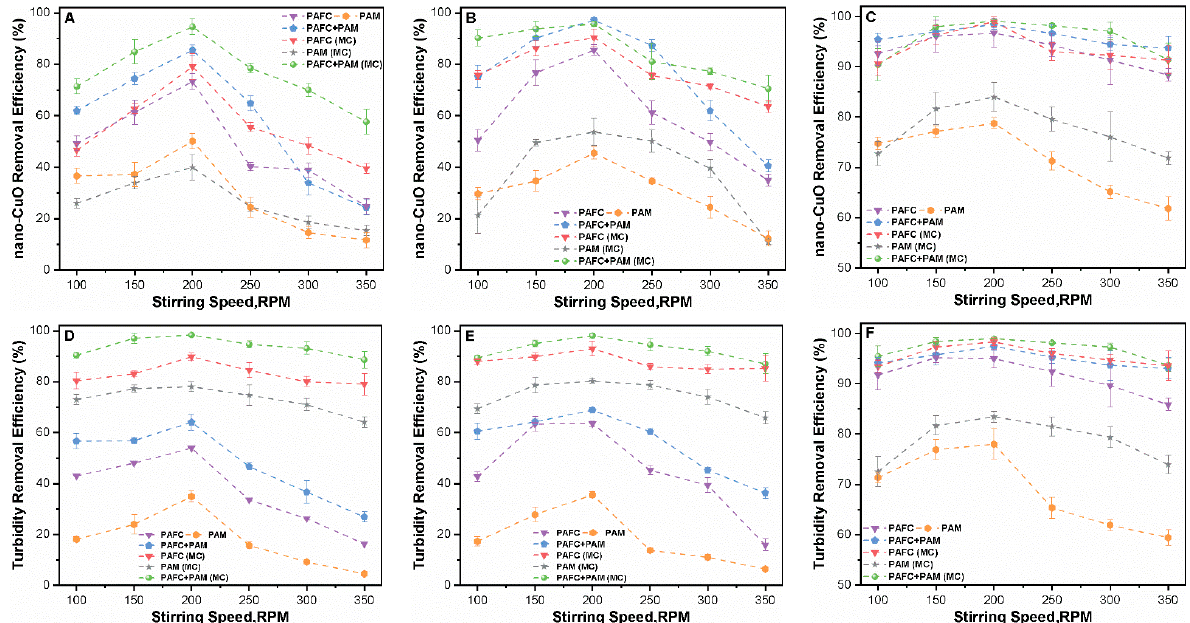
Figure 4. Influence of stirring speed (100–350 RPM) on the removal performance of nano-CuO and turbidity for various initial mass concentrations ( A , D ) 1 mg/L, ( B , E ) 2.5 mg/L and ( C , F ) 10